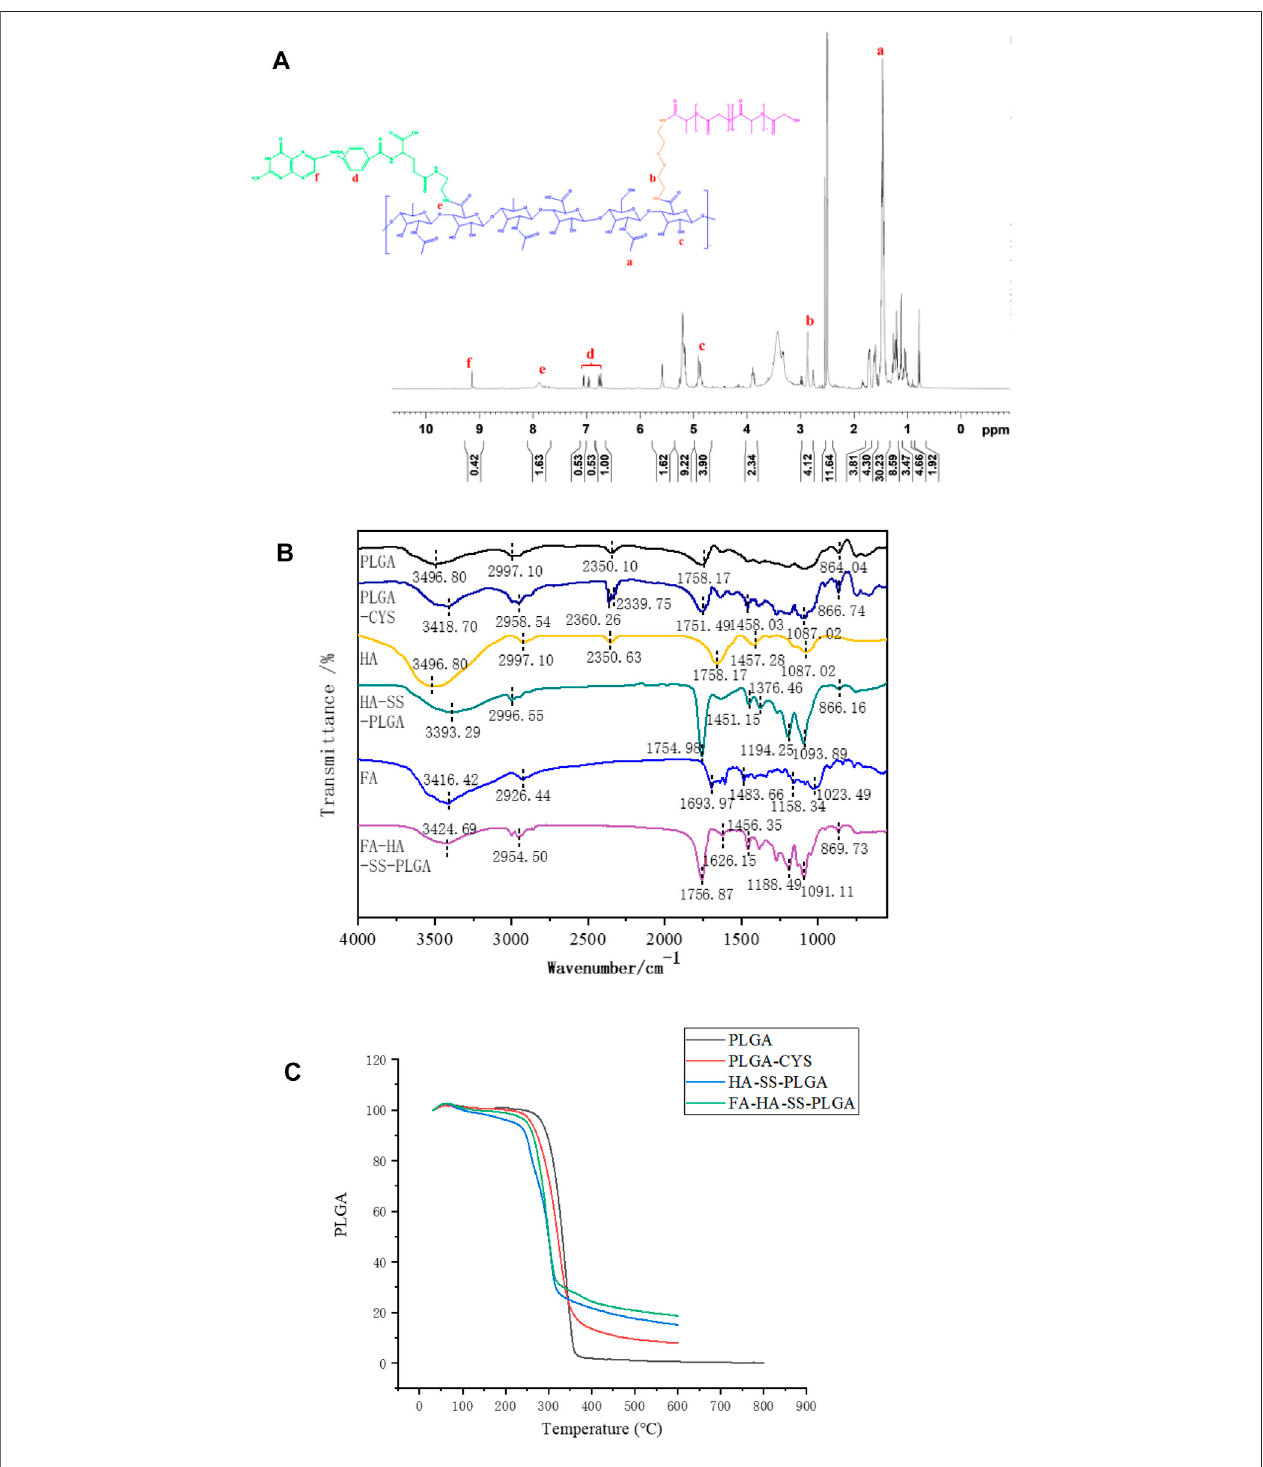
FIGURE 2 | (A) 1 H NMR spectrum of FA-HA-SS-PLGA. (B) Infrared spectra of PLGA, PLGA-CYS, HA, HA-SS-PLGA, FA, and FA-HA-SS-PLGA. (C) Thermogravimetric analysis curves of PLGA, PLGA-CYS, HA-SS-PLGA, and FA-HA-SS-PLGA.